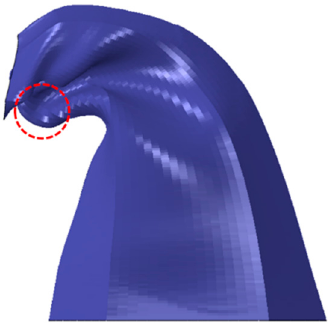
Figure 14. Fold-like bulge of core tube of panel ‘2–2–1.2–10–3.’